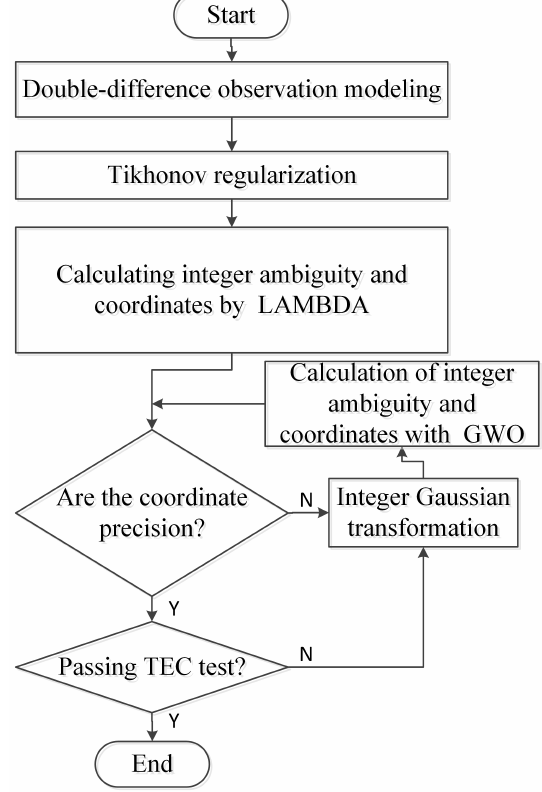
Figure 1. Parameter identification scheme of integer